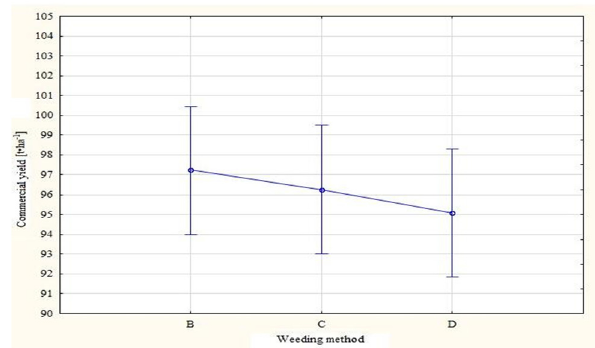
Figure 9: The expected marginal averages for 0.95 con fi dence intervals for total yield according to the various methods of weeding carrots in 2017 ( source: own work )